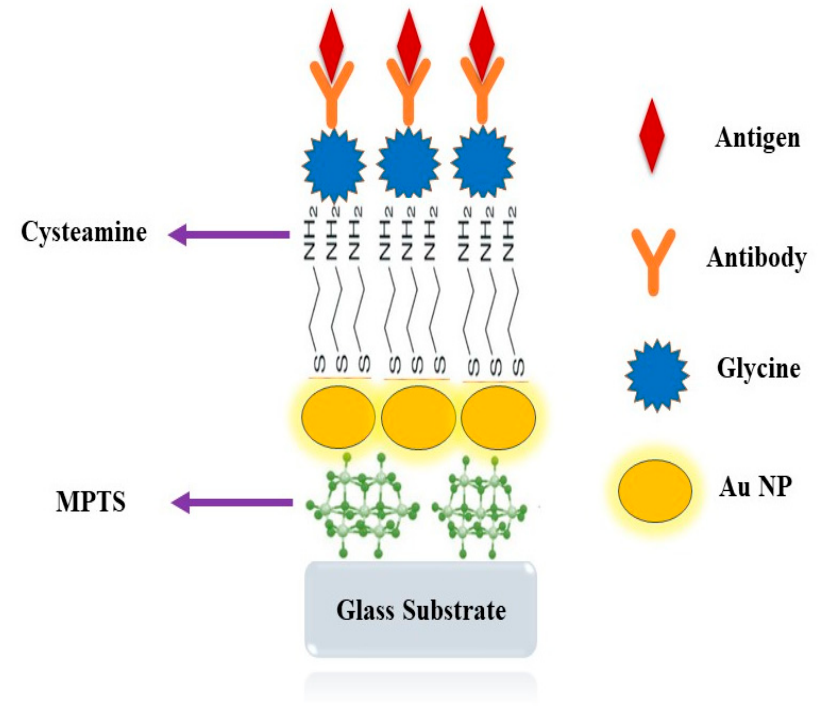
Figure 2. Schematic representation of sensing platform development.